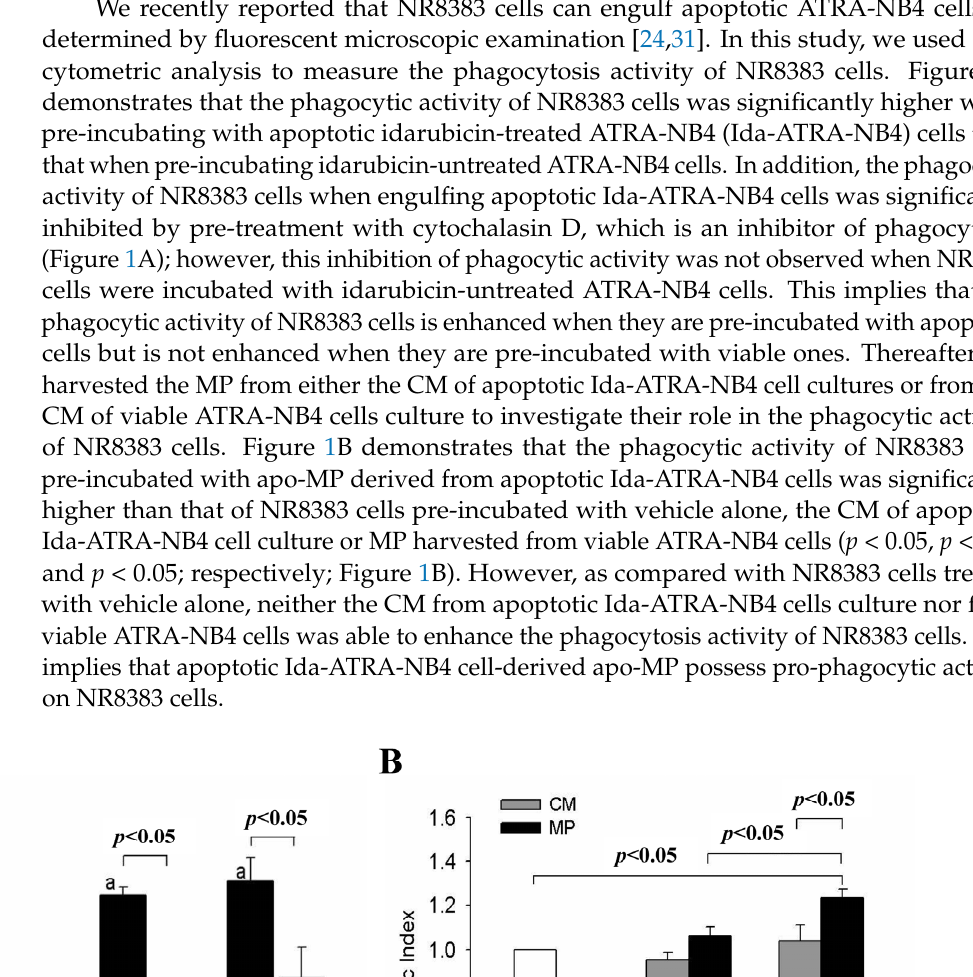
Table 1. Idarubicin Induces ATRA-NB4 Cells to Enter the Process of Apoptosis.